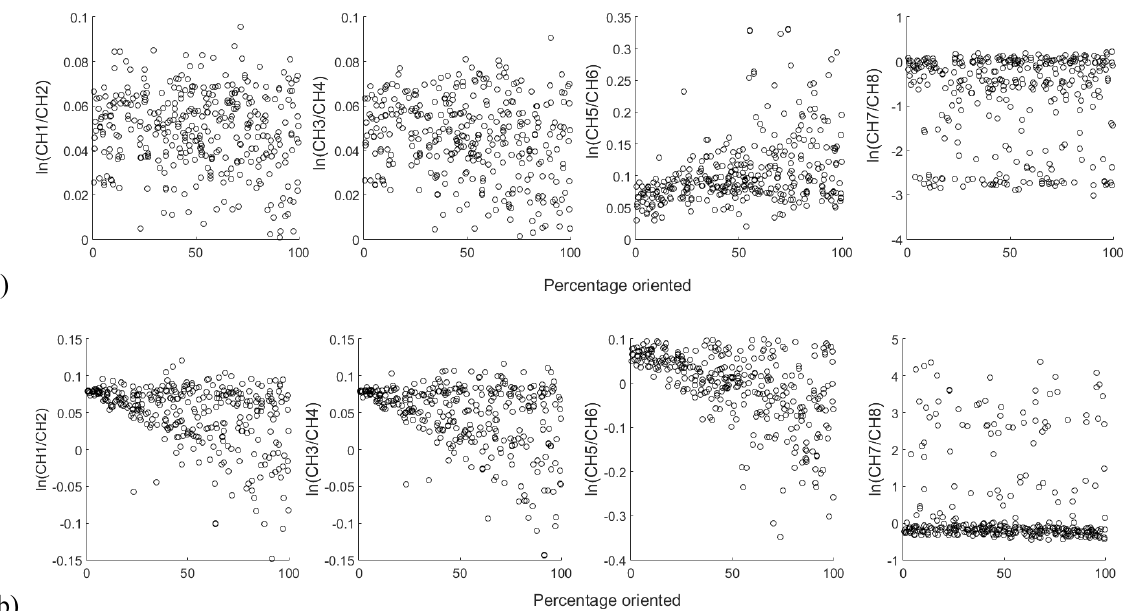
Figure 3: a) Percentage of oriented dust particles in the dust layers of the simulated atmospheric scenes, plotted versus the ratios of the logarithms of the signals (from left to right) ln(CH1/CH2), ln(CH3/CH4), ln(CH5/CH6) and ln(CH7/CH8), for backscattered light at 532 nm, viewed by the lidar with 60 o from zenith. b) The same with (a), for backscattered light at 1064